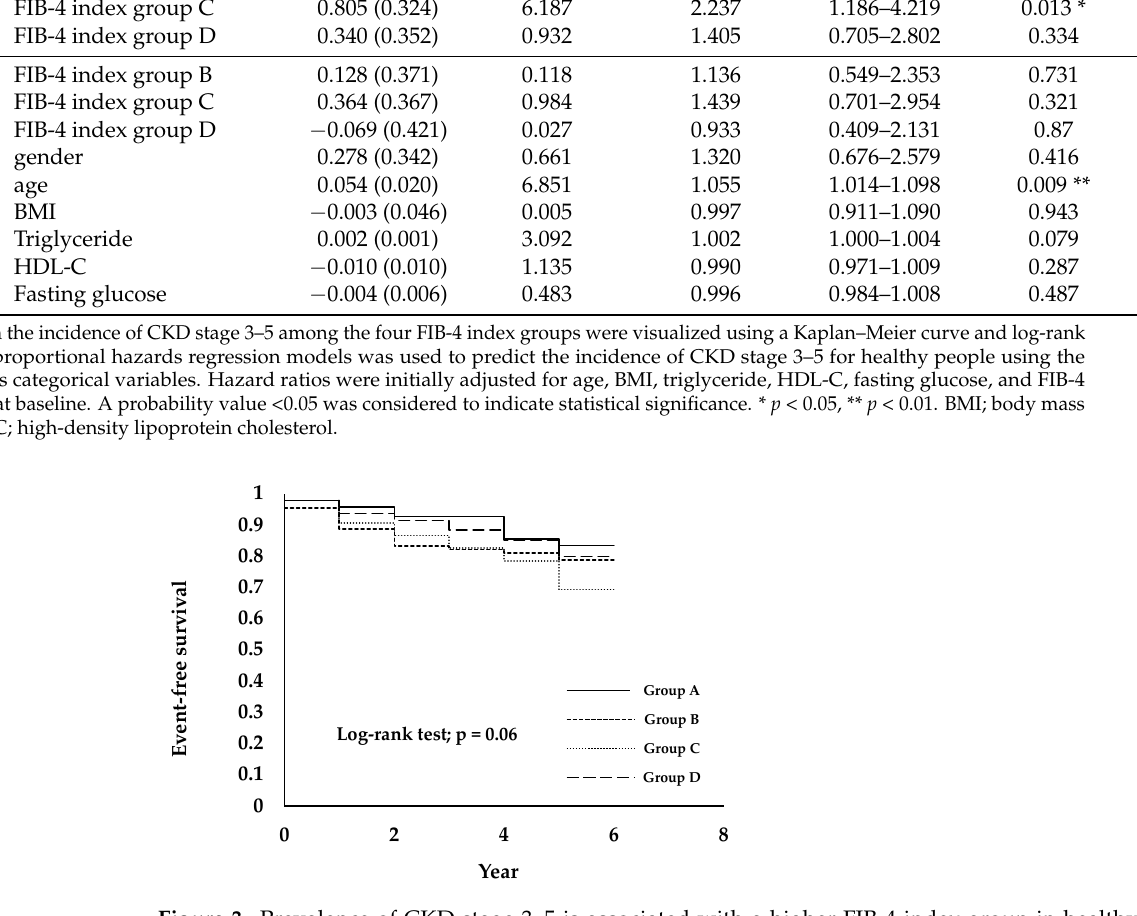
Figure 3. Prevalence of CKD stage 3–5 is associated with a higher FIB-4 index group in healthy people. Subjects were divided into four groups, as follows: Group A was 0.80 or less (<0.80), Group B was between 0.80 and 1.02 ( ≥ 0.80, <1.02), Group C was between 1.02 and 1.32 ( ≥ 1.02, <1.32), and Group D was 1.32 or greater ( ≥ 1.32).